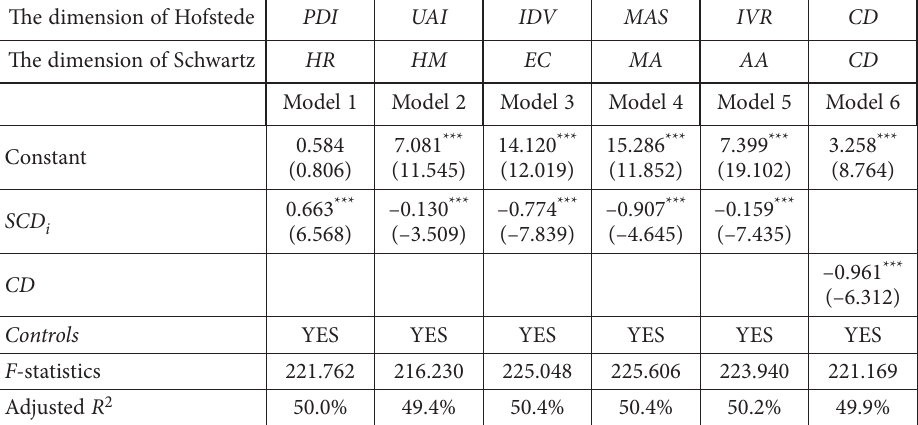
Table 8. Regression results of Schwartz cultural dimensions on IPO underpricing (source: authors’ calculation) The dimension of Hofstede PDI The dimension of Schwartz